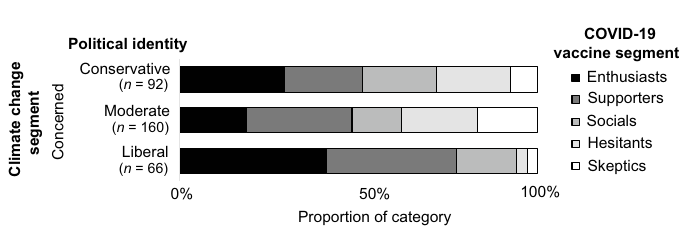
Figure 3. Vaccine segment distributions within the Concerned climate segment for participants with conservative, moderate, and liberal political identities.